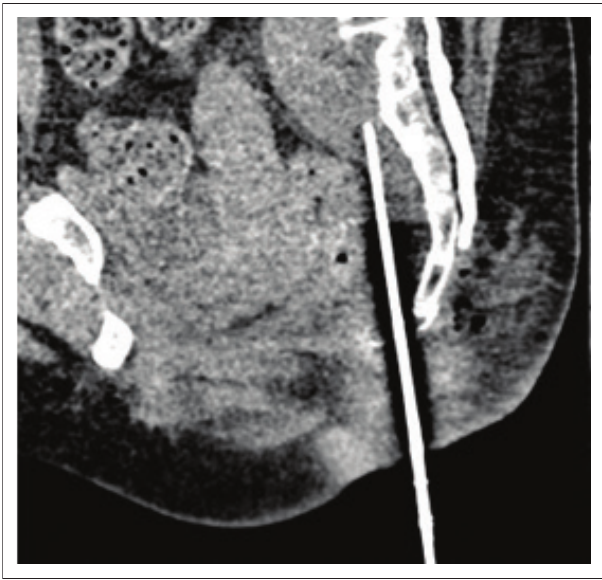
FIGURE 5: Oblique sagittal multiplanar reconstruction image indicating the 18G co-axial needle advanced cranially into the collection. Upon aspiration, thick viscous content was obtained which was sent for histo-pathological analysis in a sterile